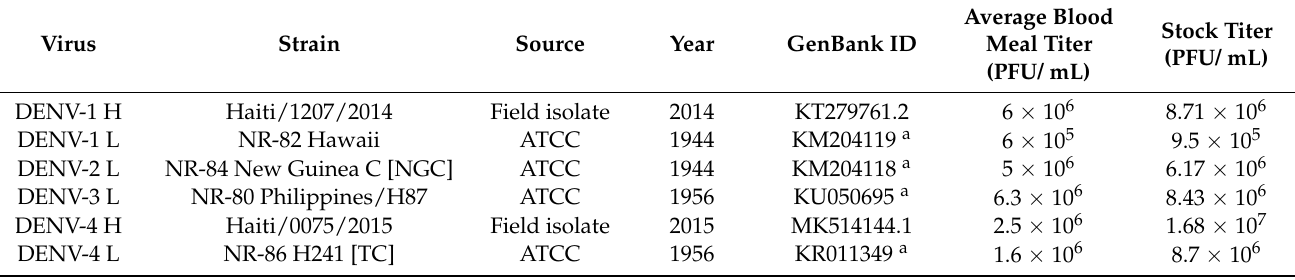
Table A1. Dengue virus (DENV) strains and sources used in experiments.